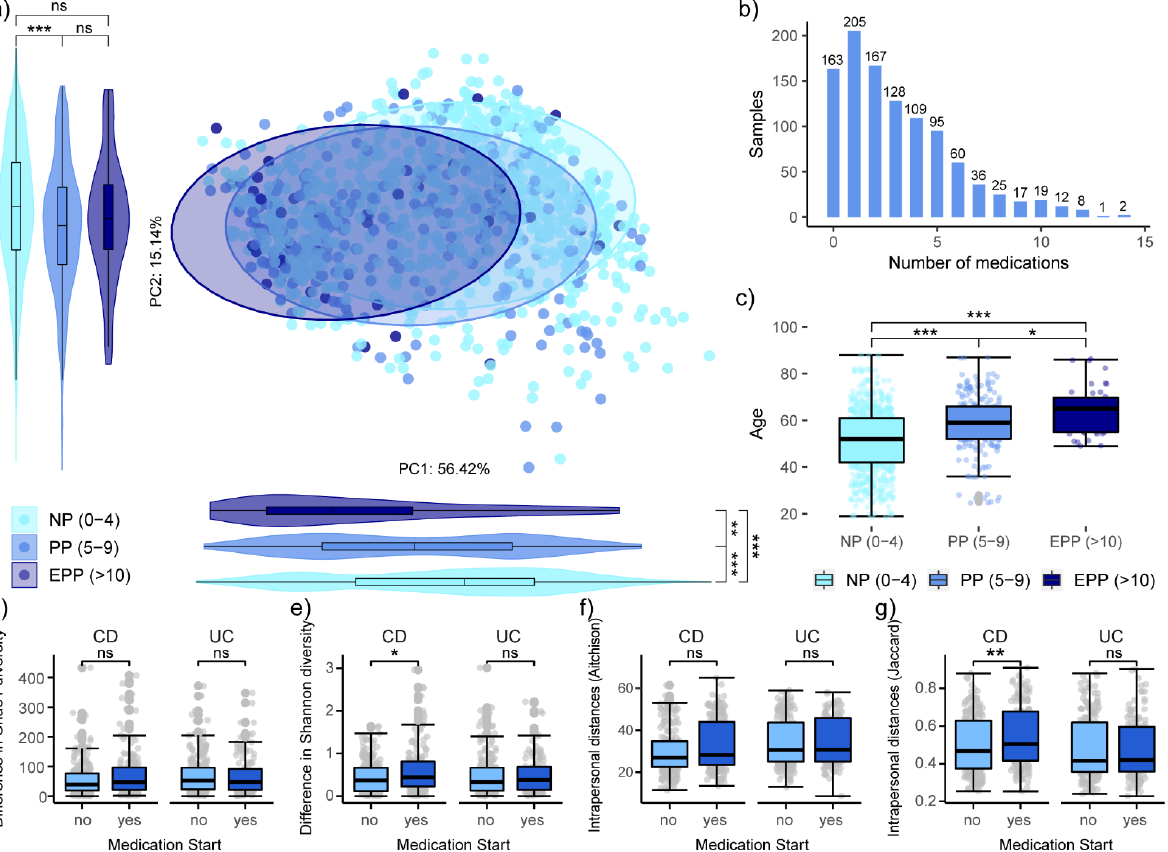
Figure 5. ( a ) PCA based on Aitchison distances with CLR transformed OTUS with a prevalence of at least 10% grouped by polypharmacy. Violin plots show projections of the PCA points onto PC1 and PC2 ;( b ) histogram of the number of medications used per sample; ( c ) comparison of the age of participants between the polypharmacy groups. Comparison of intra-personal: ( d ) Chao1